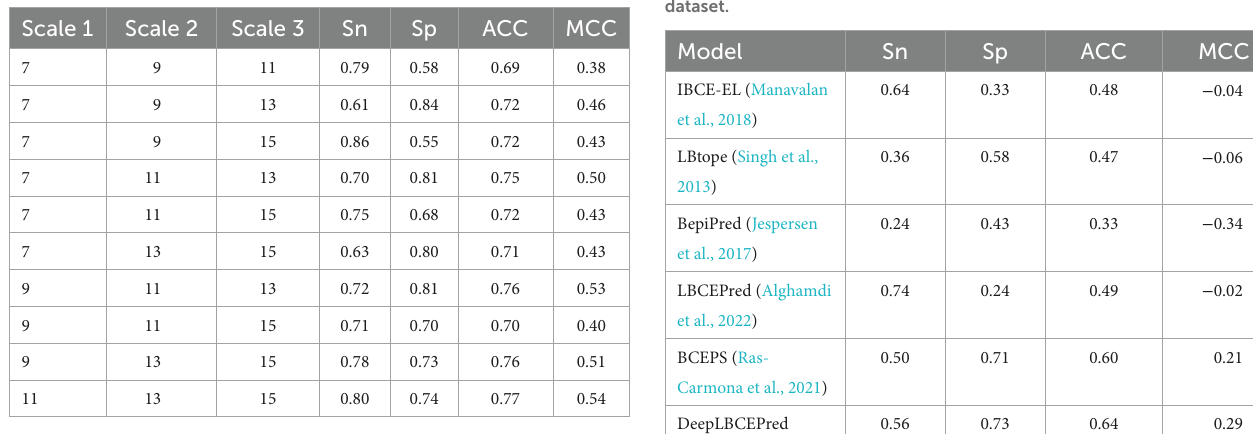
TABLE 3 Performance of different scale combinations.